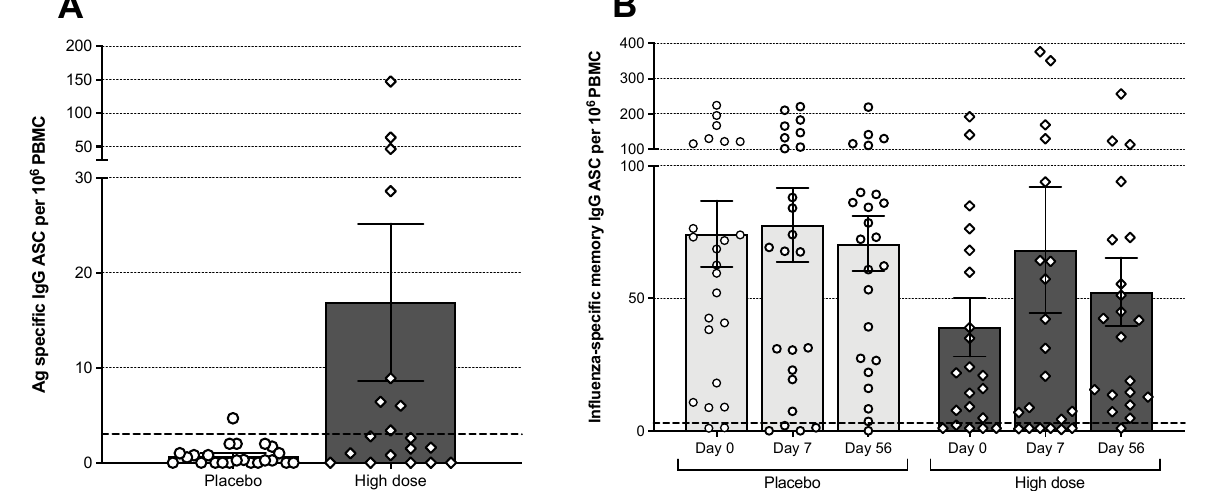
Figure 5. ( A ) Quantities of circulating influenza virus-specific antibody-secreting cells on day 7 post-vaccination. ASC: antibody-secreting cell. PBMC: peripheral blood mononuclear cells. Bars represent the mean with error bars showing the standard error. Number of samples analyzed: 19 for high-dose M2SR and 23 for placebo. ( B ) Influenza virus-specific memory B cells in circulation before, 7 and 56 days after vaccination. PBMC from M2SR high-dose and placebo cohorts were tested in memory B cell (IgG) ELISpot assay after four days of stimulation with B-Poly-S TM for polyclonal expansion of memory B cells. Results over 3 per 10 6 (dashed line) were considered above background.